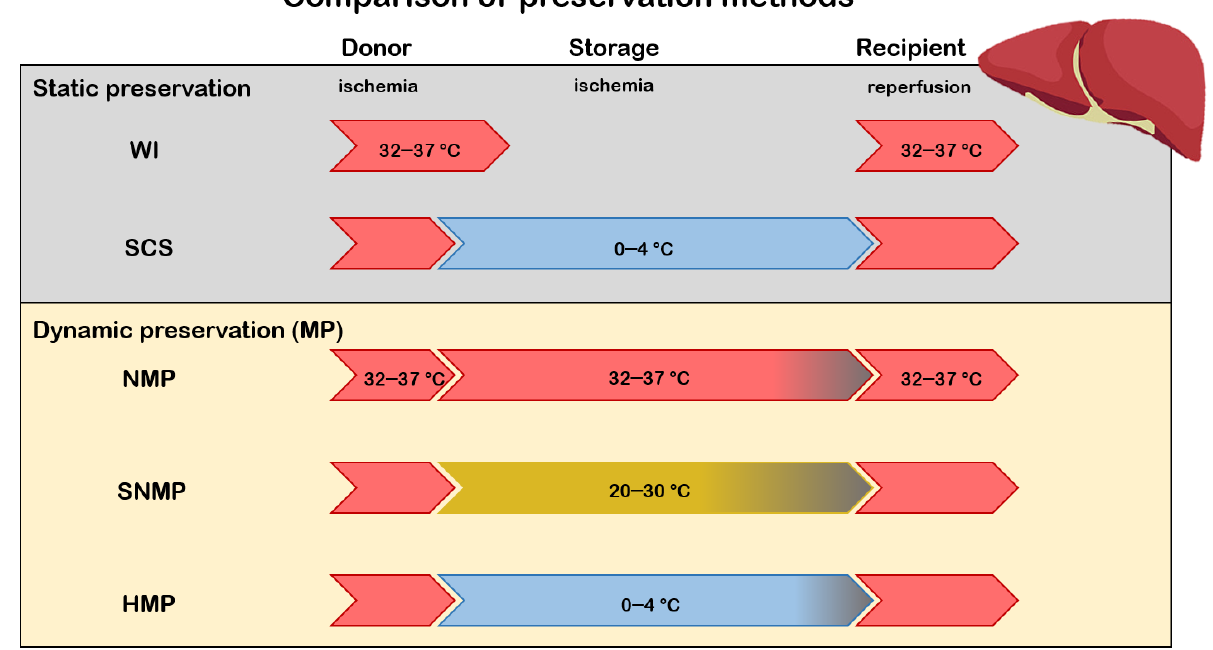
Figure 1. Comparison of different preservation methods. Upon transplantation, the graft undergoes consecutive stages of ischemia-reperfusion (IR). WI: liver grafts are exposed to warm ischemia to simulate donation after circulatory death (DCD); SCS: grafts after procurement from donors are exposed to cold ischemia during storage and organ transport. Dynamic preservation maintains organ perfusion using pulsatile machine perfusion (MP). MP can be divided into subgroups according to the temperature of the perfusate as normothermic machine perfusion (NMP), subnormothermic machine perfusion (SNMP) and hypothermic machine perfusion (HMP). The different colors of the arrows represent the temperature of the environment. Red indicates a 32–37 °C environment, blue demonstrates 0–4 °C, and yellow represents 20–30 °C.